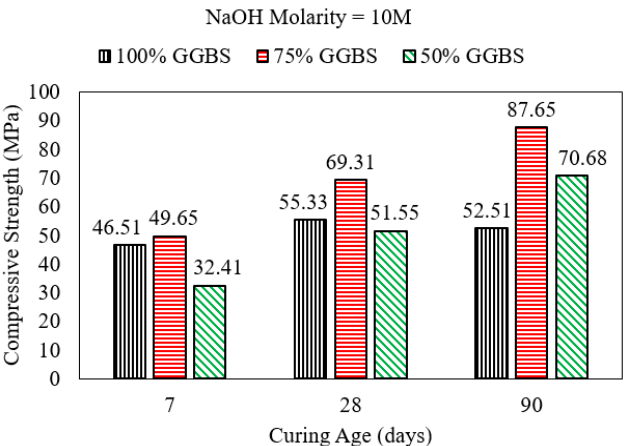
Figure 12. Strength development of mortar with an AASF binder immersed in sulfuric acid [6].